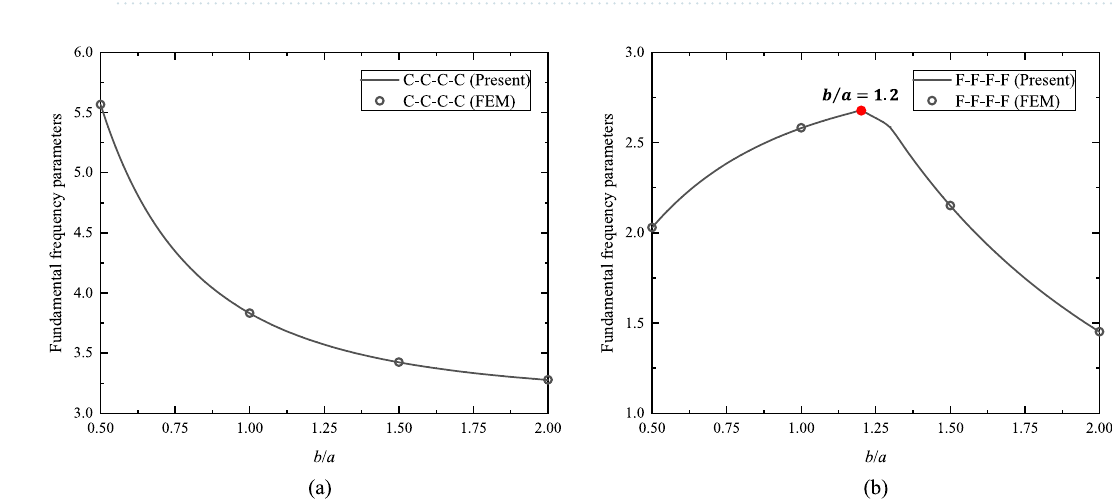
Figure 4. Fundamental frequency parameters ( (cid:31) ort ) versus b orthotropic F–F–F–F plates, with E y